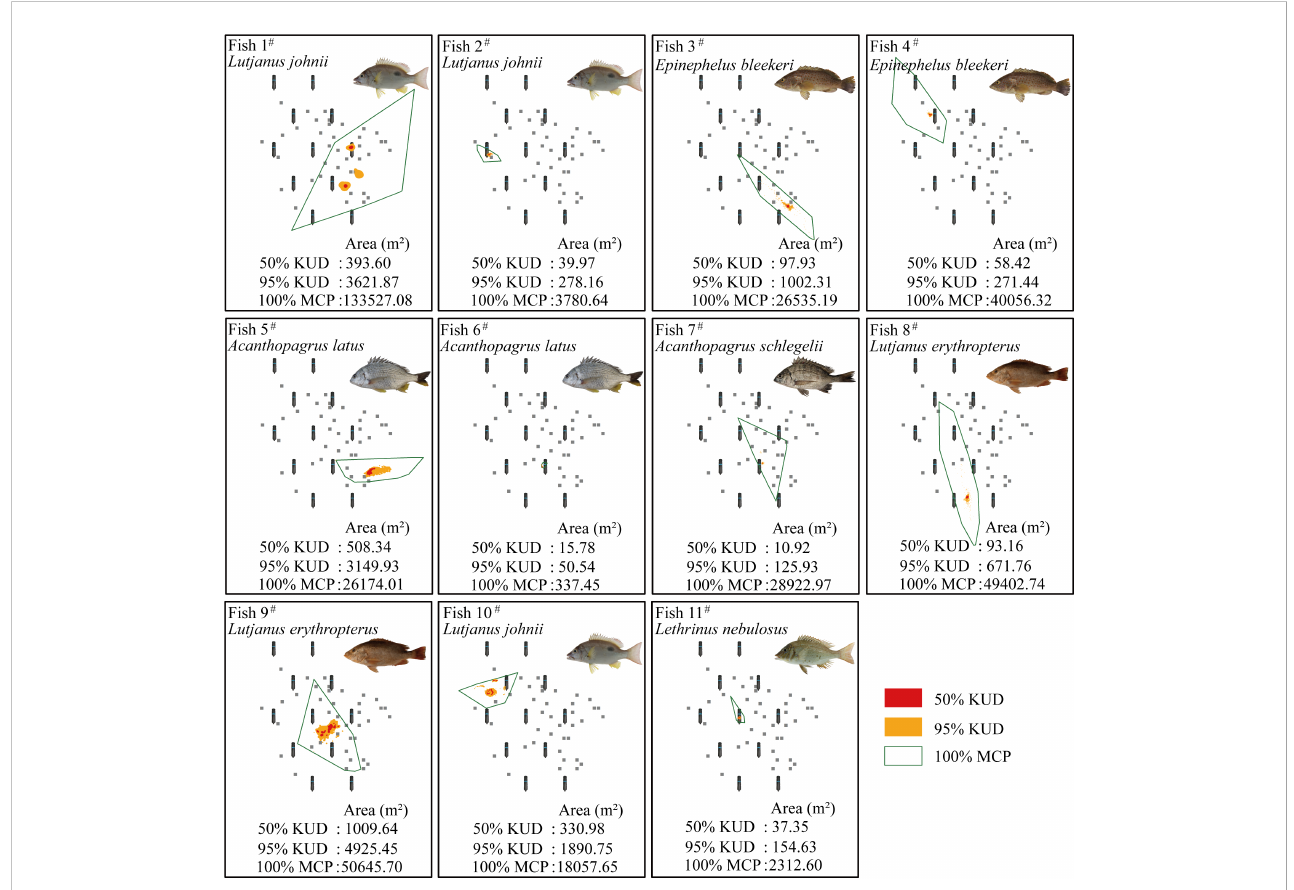
FIGURE 6 Spatial plot of the habitat use range with the minimum convex polygon (100% MCP) and kernel utilization distribution (95% and 50% KUD) for 11 tagged fi sh in the Fangchenggang arti fi cial reef sea area. MCP, minimum convex polygon; KUD, kernel utilization distribution.